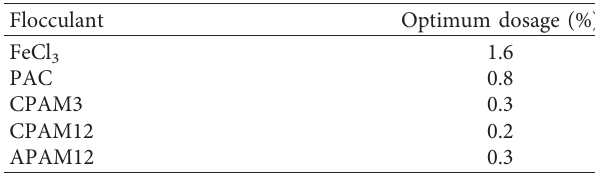
Table 3: Optimum dosage of flocculants.